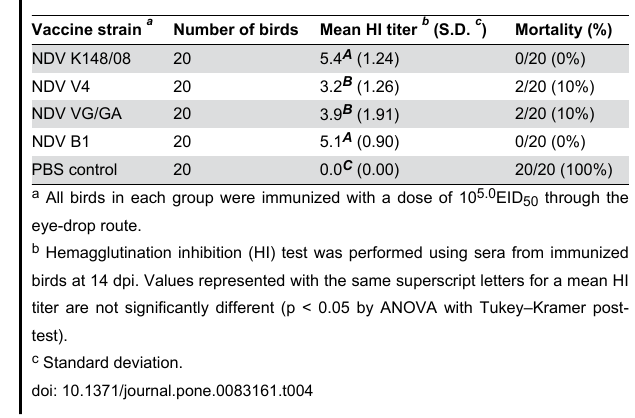
Table 5. Immunogenicity and protective efficacy in day-old SPF chicks vaccinated using a cabinet-type fine sprayer with the NDV K148/08 strain and followed by challenge with genotype VII vvNDV.